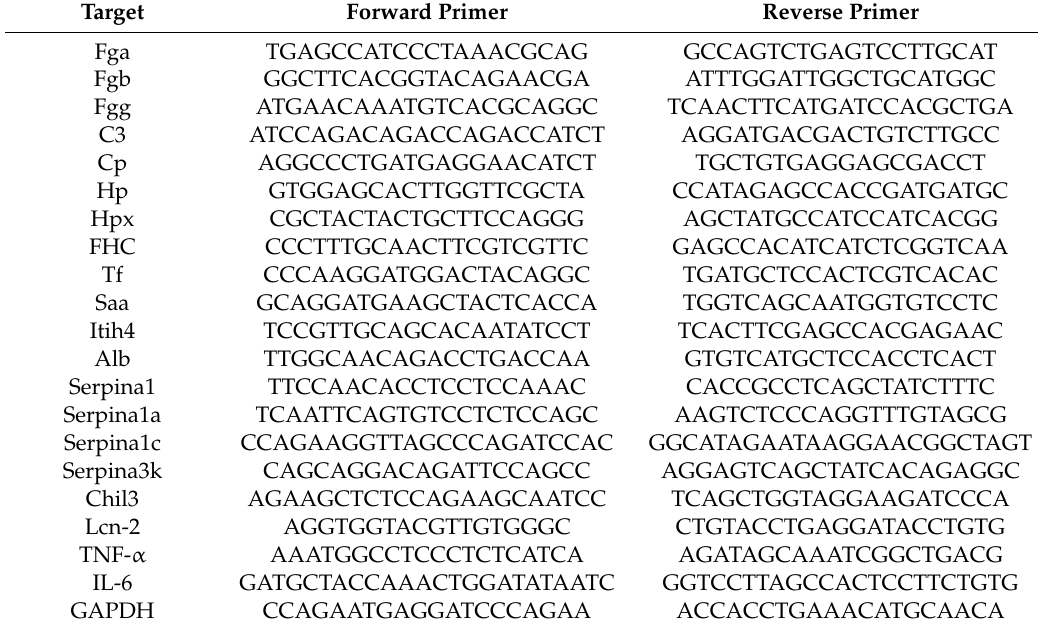
Table 5. Sequences of primers used for measuring the expression of target genes by qPCR. Fga: fibrinogen- α , Fgb: fibrinogen- β , Fgg: fibrinogen- γ , C3: complement C3, Cp: ceruloplasmin, Hp: haptoglobin, Hpx: hemopexin, FHC: ferritin heavy chain, Tf: transferrin, Saa: serum amyloid